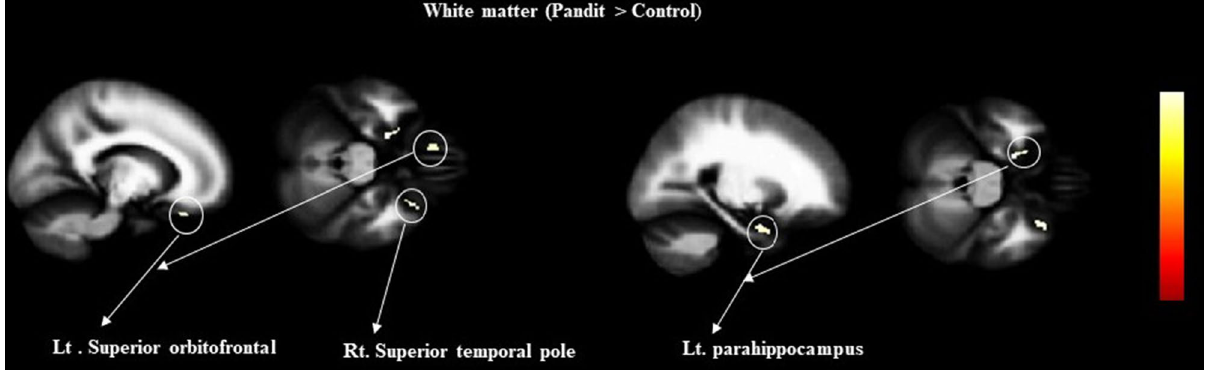
Figure 2. Results of VBM group comparison rendered into standard stereotactic space and superimposed on to magnetic resonance image (MRI) which is itself in standard space. The image showsincreased WM value in Pandit/Priest as a result of the two-sample t -test comparing with the Control, at a threshold of P < 0.05 (FWE) corrected.